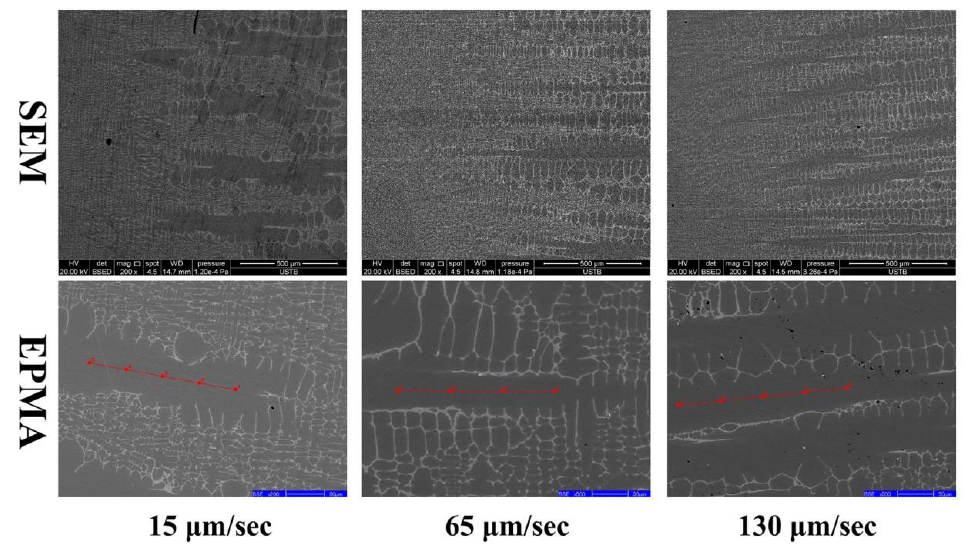
Figure 6. The microstructure of solid–liquid interface under different pulling rate. Element redistribution is the result of the superposition of back ‐ diffusion onto the micro ‐ segregation [29]. In order to characterize the element redistribution degree, R D (cid:2887) (cid:3167)(cid:3172)(cid:3178)(cid:3163)(cid:3176)(cid:3162)(cid:3163)(cid:3172)(cid:3162)(cid:3176)(cid:3167)(cid:3178)(cid:3167)(cid:3161)(cid:3171)(cid:3159)(cid:3182) , C (cid:2919)(cid:2924)(cid:2930)(cid:2915)(cid:2928)(cid:2914)(cid:2915)(cid:2924)(cid:2914)(cid:2928)(cid:2919)(cid:2930)(cid:2919)(cid:2913)(cid:2923)(cid:2911)(cid:2934) is the maximum element content in interdendritic, C ( ( R (cid:2888) (cid:3404) (cid:2887) (cid:3162)(cid:3163)(cid:3172)(cid:3162)(cid:3176)(cid:3167)(cid:3178)(cid:3163) (cid:3159)(cid:3176)(cid:3171)(cid:3171)(cid:3167)(cid:3172) is the minimum element content in dendrite arm ) was measured by EPMA point analysis. The measurement results are shown in Table 3. With the increase in the pulling rate from 15 μ m/sec to 130 μ m/sec, the redistribution degree of Mo element in the solidification struc ‐ ture increased from 2.33 to 3.80, and the redistribution degree of the Cr element increased from 1.15 to 1.21. As a result, the degree of element redistribution of the solidified struc ‐ ture gradually increases as the pulling rate increases. Table 3. Elemental solute partition coefficients during solidification.